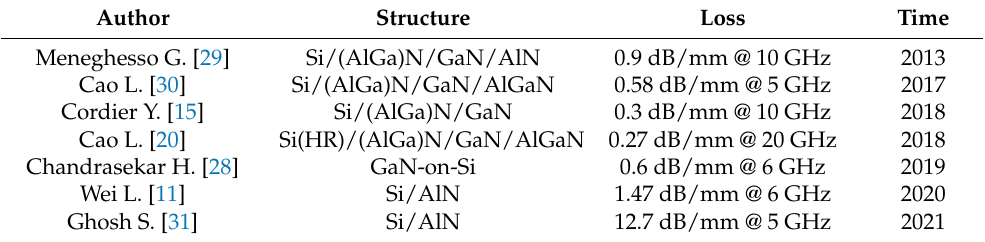
Table 4. Epitaxial structure and CPW loss of GaN-on-Si below 20 GHz reported in the literature.